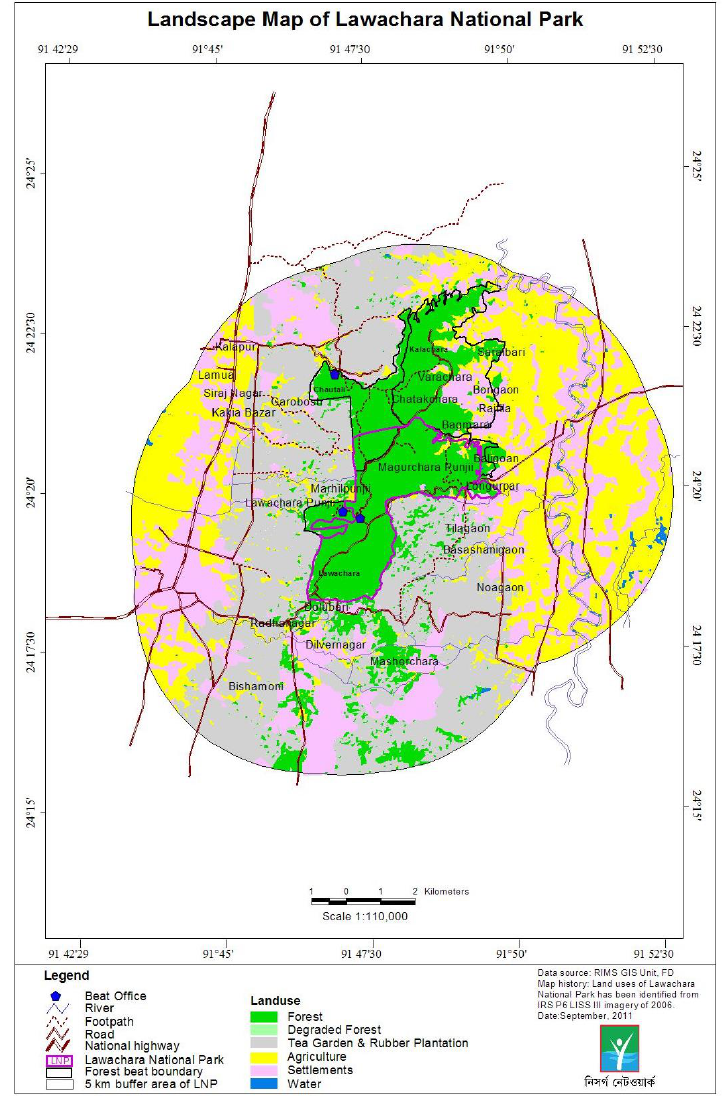
Figure 1. Landscape map of Lawachara National Park.